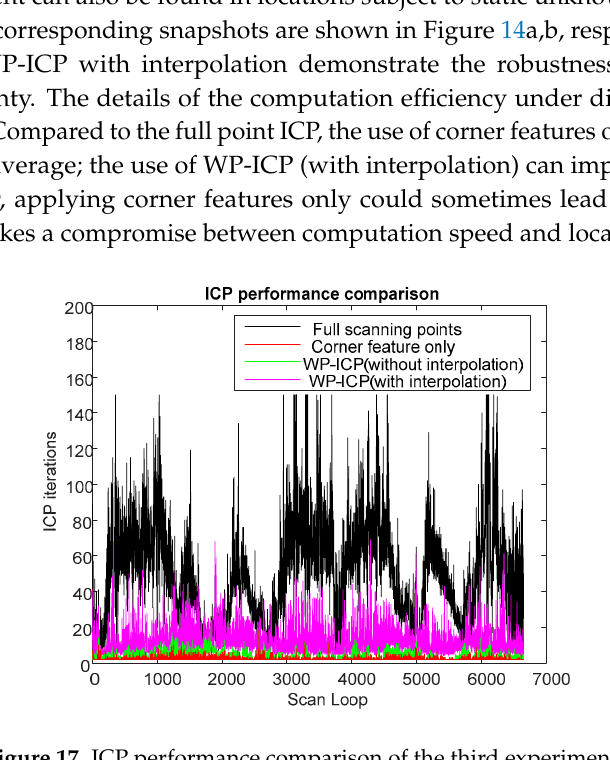
Figure 17. ICP performance comparison of the third experiment.